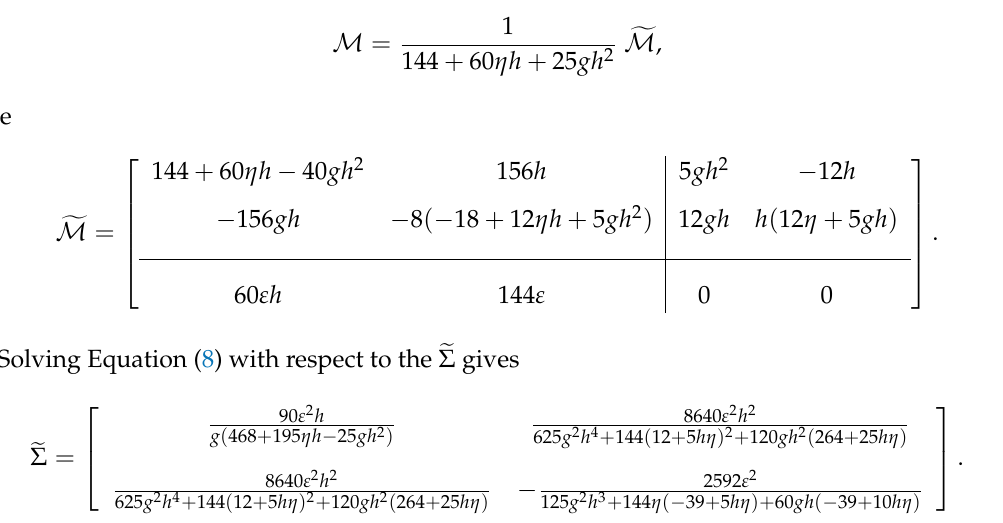
− σ 2 | (continuous line), | (cid:101) σ 2 X X